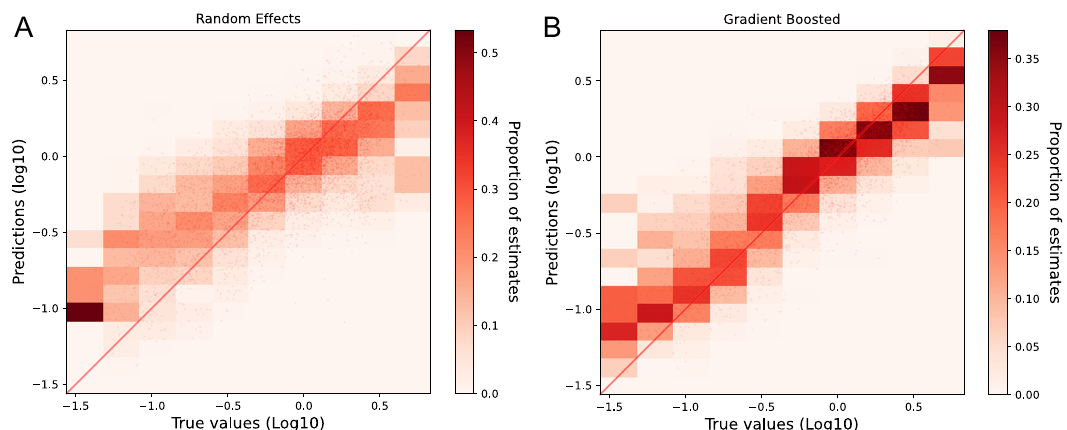
Fig. 4 Conditional predictions of SARS-CoV-2 prevalence from WW compared to the CIS positivity estimates ( “ True value ” ) in the log 10 space. A Random effects model and ( B ) gradient boosted regression tree (GBRT) model. The red line indicates the diagonal where a well- fi tted model would result in most predictions falling on the diagonal.